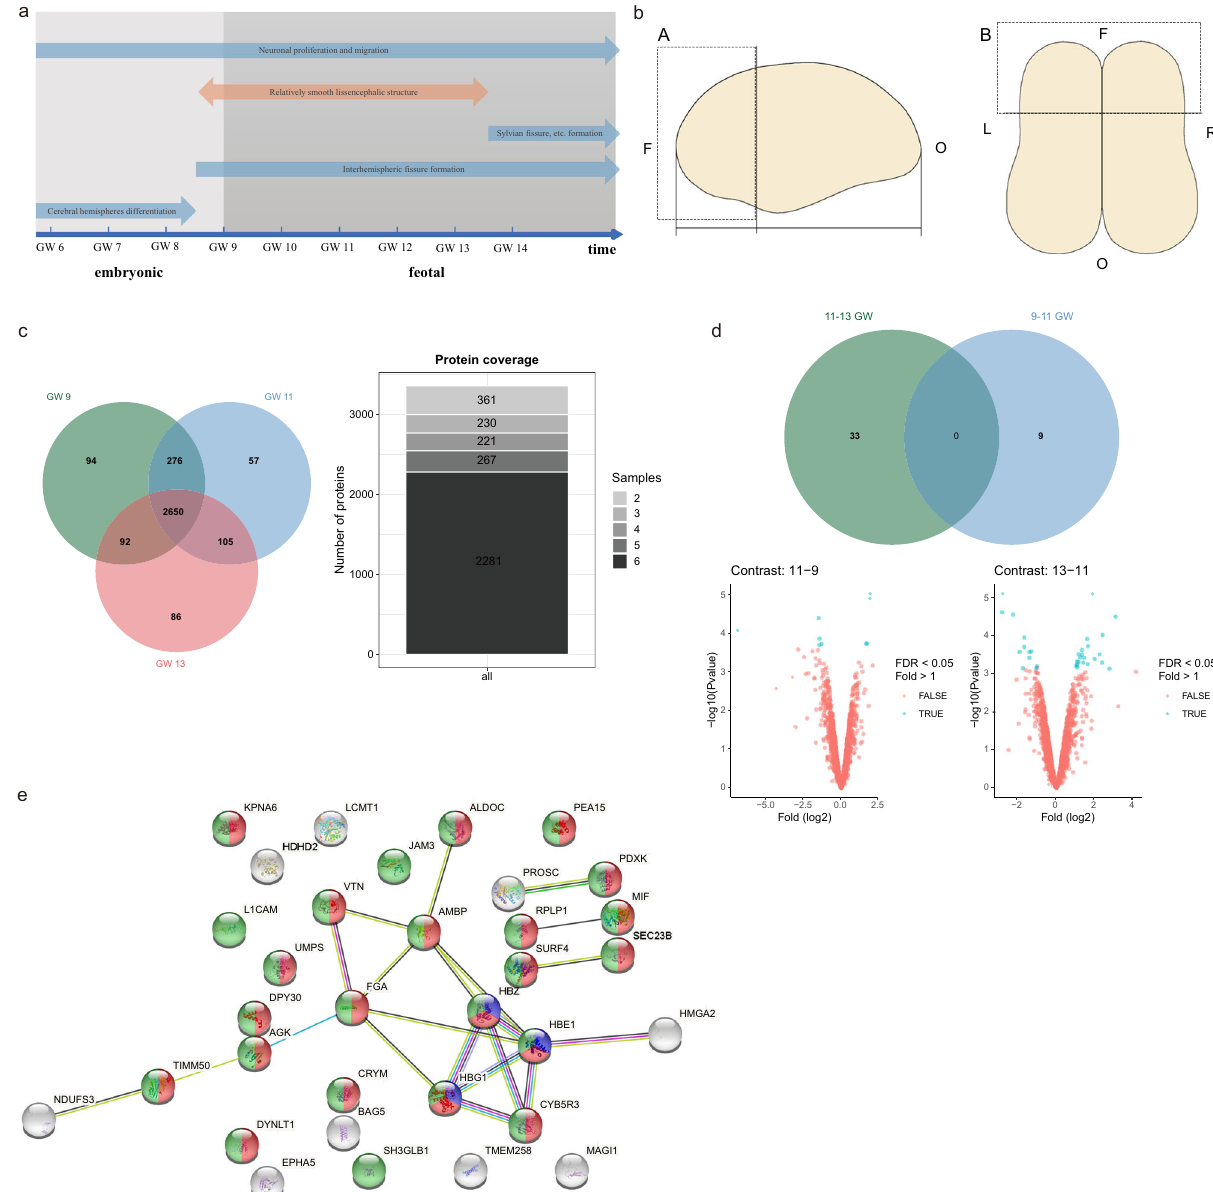
Fig. 1 Proteins identi fi ed in the fetal frontal lobes at different gestational weeks. a The time course of brain development. b Dissection of the human fetal frontal lobe. (A) A lateral view of the left hemisphere of the human fetal brain. One-third of the occipitofrontal diameter close to the frontal pole (F) as the frontal lobe is dissected. O, occipital pole. (B) A top view of the human fetal brain. Tissues were dissected from the left (L) and right (R) frontal lobes. c The protein set identi fi ed in all three samples contained 2650 proteins, and the core protein set identi fi ed in all six tissues contained 2281 proteins. d Volcano map of core proteins that showed signi fi cant differences in abundance between gestational weeks 9 – 11 and gestational weeks 11 – 13 (FDR < 0.05, log2Fold > 1). e Visualization of the PPI network of proteins showing differential expression between gestational weeks 11 and 13. The PPI network has signi fi cantly more interactions than expected (PPI enrichment p value: 7.68e-09). The nodes represent proteins, and the proteins enriched in different biological processes are indicated by the different colors; the proteins enriched in the hydrogen peroxide catabolic process are shown in purple (count = 3, FDR = 0.0405), those enriched in transport are shown in red (count = 21, FDR = 0.0027), and those enriched in localization are shown in green (count = 24, FDR = 0.0025). The edges represent the predicted interactions according to STRING. These interactions include known interactions from curated databases (light blue), experimentally determined interactions (magenta), and interactions identi fi ed by gene neighborhood (green), gene fusion (red), gene co-occurrences (blue), text mining (yellow), co-expression (black), and protein homology (purple). The whole human genome was used as the statistical background for the functional We identi fi ed multiple DEPs that play a role in neuronal 1.73, FDR = 0.050), which showed upregulated expression, and development and differentiation. In the comparison of GW 11 NDRG2 (NDRG2; log2FC = − 1.45, FDR = 0.050), which showed with GW 9, two proteins associated with neurogenesis were downregulated expression. The most downregulated protein was signi fi cantly changed as annotated by the UniProt keyword neuroblast differentiation-associated protein AHNAK (AHNAK; database, and these included alpha-internexin (INA; log2FC = log2FC = − 6.88, FDR = 0.048), which may be needed for